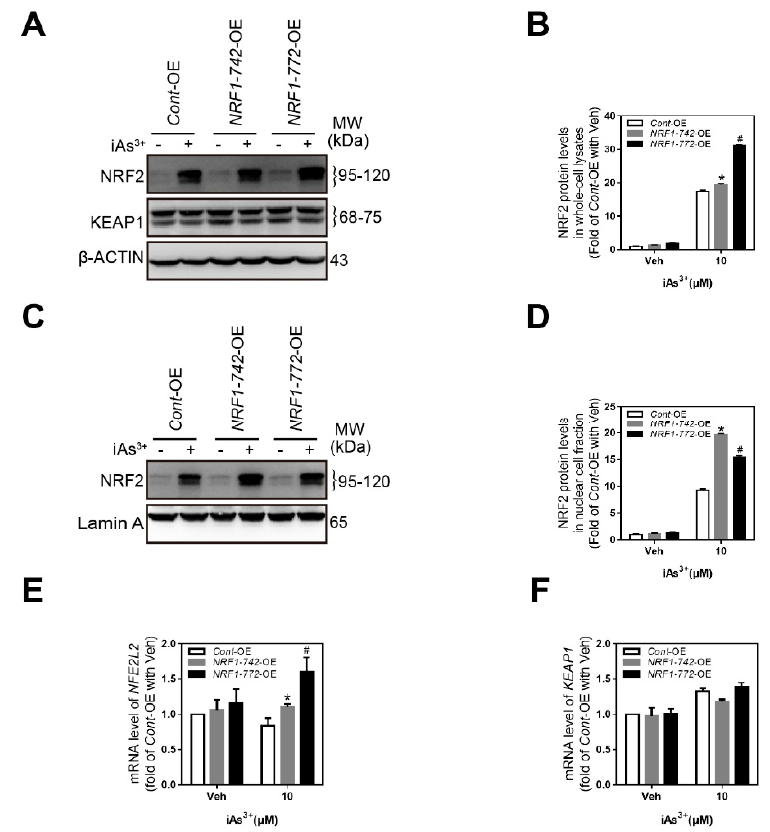
Figure 4. Crosstalk between NRF1, nuclear factor erythroid 2-like 2 (NRF2), and Kelch-like ECH- associated protein 1 (KEAP1). Cells were exposed to 10 µ M iAs 3 + or vehicle for 6 h. Immunoblotting of NRF2 in whole-cell lysates ( A ) and nuclear cell fractions ( C ). Quantification of NRF2 bands in whole-cell lysates ( B ) and the nuclear fractions ( D ). (E-F) RT-qPCR analysis of NRF2 and KEAP1 expression in response to acute iAs 3 + exposure ( n = 6). The data are presented as the mean ± SD; * p < 0.05, NRF1-742 -OE versus Cont -OE HaCaT cells; # p < 0.05, NRF1-772 -OE cells versus Cont -OE HaCaT cells.